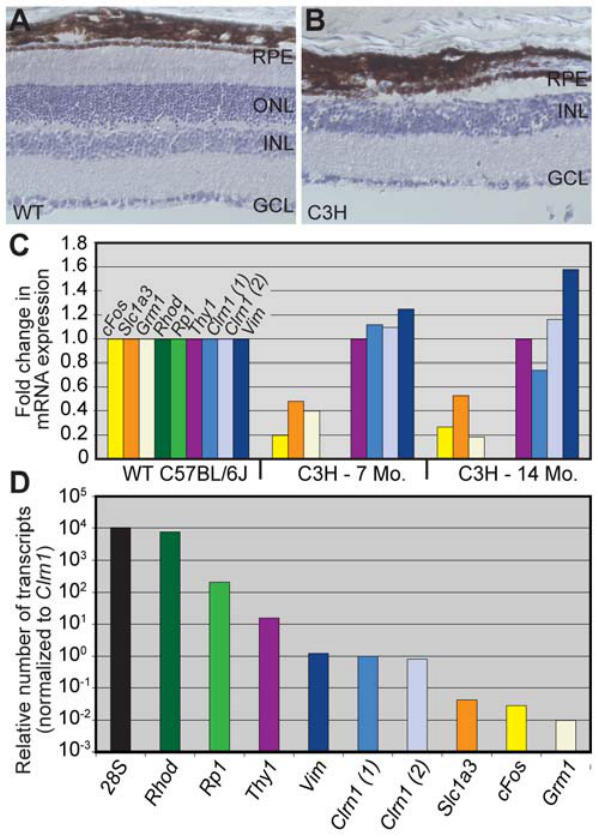
Figure 4. Analysis of Clrn1 in WT and photoreceptorless C3H/ HeJ aged mouse retinas. (A,B) Sixteen micron cryosections of WT (A) and degenerated C3H (B) mouse retinas counterstained with hematox- ylin. Note the virtual complete loss of photoreceptors in the 14 month C3H retina. (C) Real-time quantitative (q) RT–PCR was performed in order to correct for the RNA contribution of the outer retina in the WT cDNA sample. The data were normalized to the ganglion cell marker Thy1 , and subsequently to expression levels in the WT sample. For comparison purposes, several additional known retinal transcripts were included in the qRT–PCR analysis. (D) Relative transcript expression levels in retinas from WT and photoreceptorless animals. Normalizing to a Clrn1 primer pair, the range in the abundance of non-Clrn1 transcripts was 100-fold fewer (Grm1) to 10,000-fold higher ( Rhod ). Scale bar=50 m m in all images. ONL=outer nuclear layer, INL=inner nuclear layer, and GCL=ganglion cell layer.